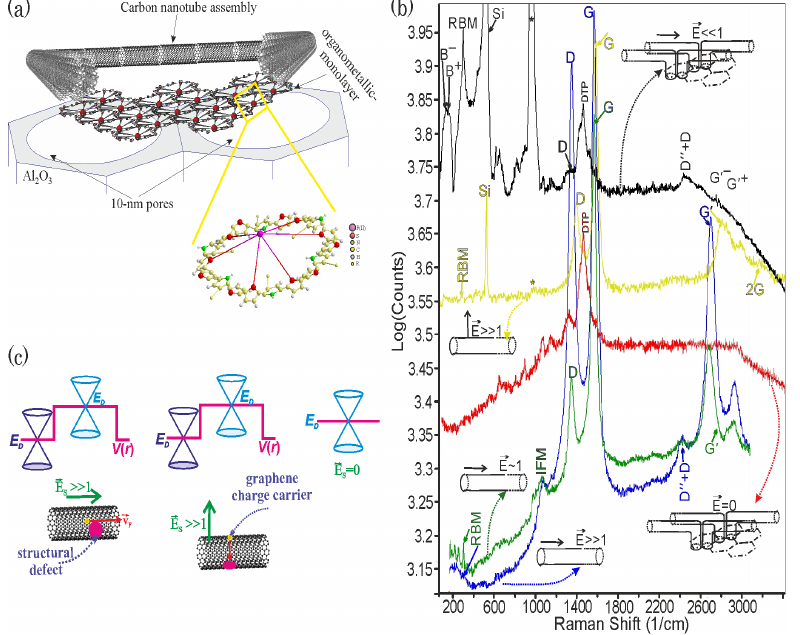
Figure 3. ( a ) Aligned CNT assembly within a bilayer suspended on AOA nanopores on which the organometallic compound monolayers were deposited preliminarily. Inset: structure of the organometallic nanocyclic complex Fe(II)DTP. ( b ) The Raman spectra for CNT two- and three- monolayer LB films deposited on different supports: yellow for the three-monolayer CNT film on Si, whose surface was preliminarily modified by a drop of the H-DTP solution in hexane; black and red for the LB films consisting of five Fe(II)DTP monolayers and two CNT monolayers deposited on Si (the black curve) and on the 10 nm porous AOA membrane (the red curve), whose surfaces were preliminarily modified by a drop of the H-DTP solution in hexane; green for the two-monolayer CNT film deposited on the 10 nm porous AOA, whose surface was preliminarily hydrophobized by the stearic acid; blue for the two-monolayer CNT film deposited on the 10 nm porous AOA, whose surface was preliminarily hydrophilized by the FWCNT solution in hexane. The Raman spectra were recorded at laser excitation wavelengths of 355 (the yellow line), 473 (the green and blue lines), and 532 (the black and red lines) nm; the following laser powers and collection times were used for the specimen excitation: 0.6 mW and 10 s (the red line), 2 mW and 30 s (the yellow line), 5.76 mW and 40 s (the green and blue lines), 14.4 mW and 10 s (the black line). Symbols “Si” and “*” denote the vibrational modes of Si at 519.57 cm − 1 and the laser mode at a frequency of 980 cm − 1 , respectively. ( c ) Mechanisms of action of electrical fields, (cid:126) E s , from the CNT environment. The energy band, E D , touching at the Dirac point in a graphene patch shifts under the action of (cid:126) E s with and without the formation of resonances as a result of Klein tunneling at oblique (c, left) and transversal (c, middle) scattering of graphene charge carriers, q G , respectively, on the potential barriers V ( (cid:126) r ) of the structural graphene-plane defects induced by the dipole polarization and electrification of the support. The energy of the Dirac touching shift is lacking at the zero field (cid:126) E s (c, right). The charge carriers move at the Fermi velocity, v F